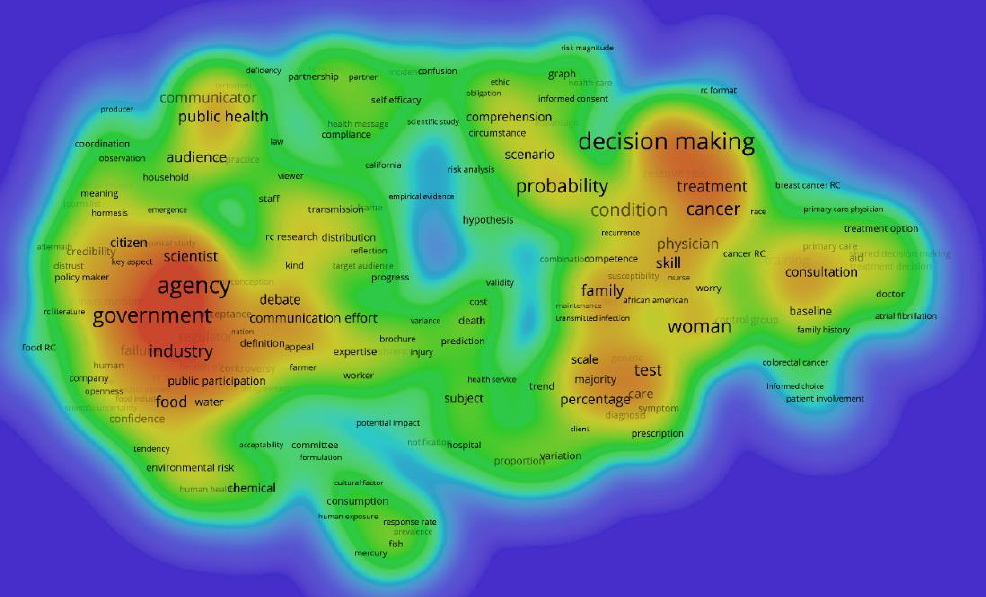
Figure 7. Term density map of risk communication research, average publication year before 2010, (227 terms included).